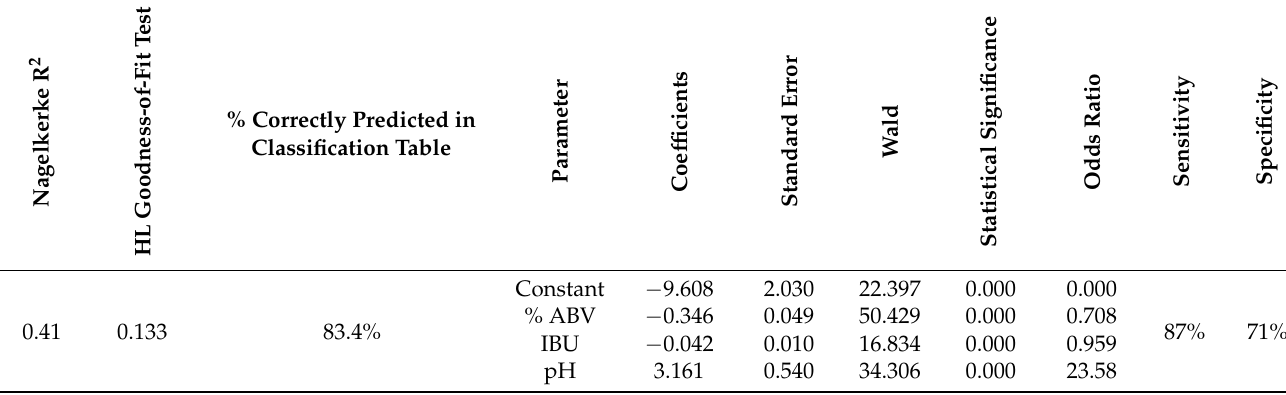
Table 3. Modeling results and variables/coefficients values included in the